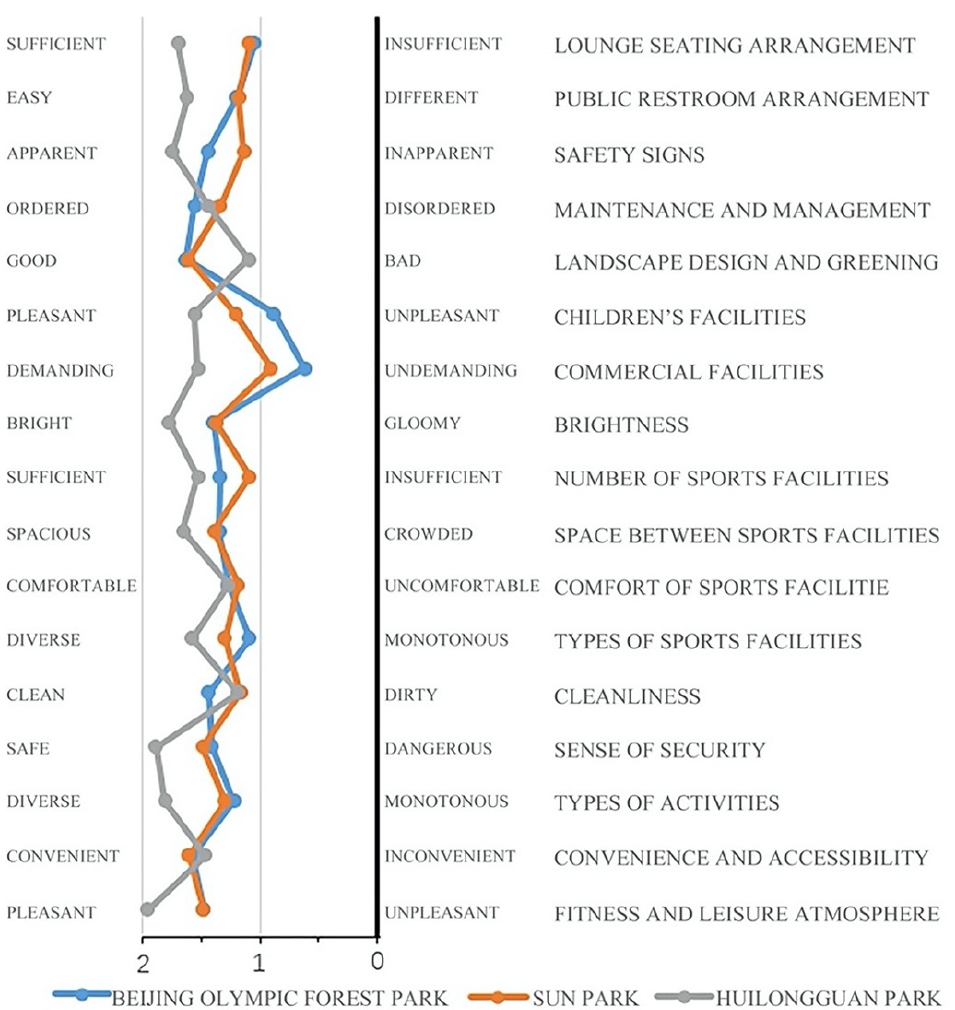
Figure 6. SD evaluation curves of three sports park spaces.